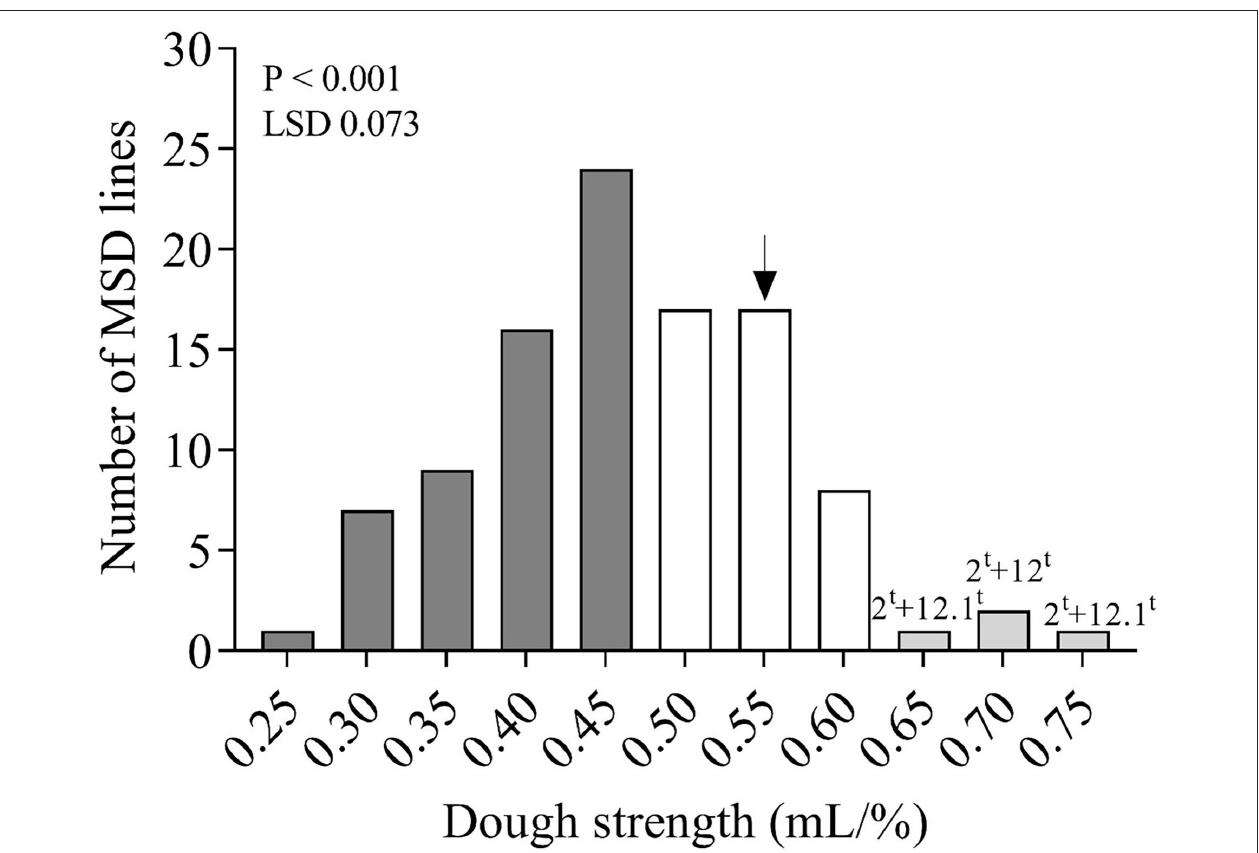
FIGURE 3 | Distribution of the mean dough strength (mL/%) of 103 MSD lines that derived their HMW-GS from Ae. tauschii and the recurrent parent N61, shown by a black arrow. Dark gray, white, and light gray columns indicate the number of lines in the MSD panel that had significantly lower, comparable, or higher dough strength than N61, respectively. Numbers and letters above the columns indicate the important subunit pairs in the MSD lines that had dough strength superior to N61. LSD stands for least significant